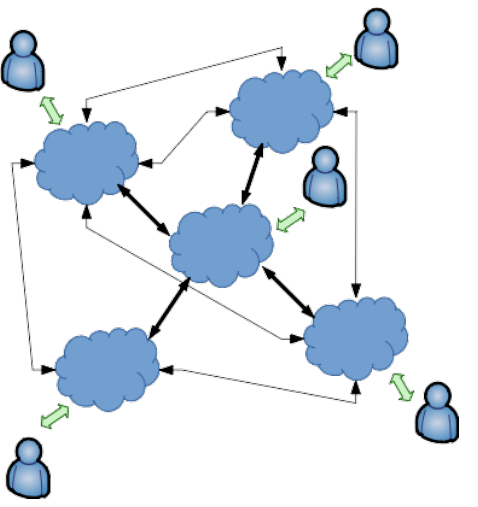
Fig.1. Cloud-bursting “mesh” scheme